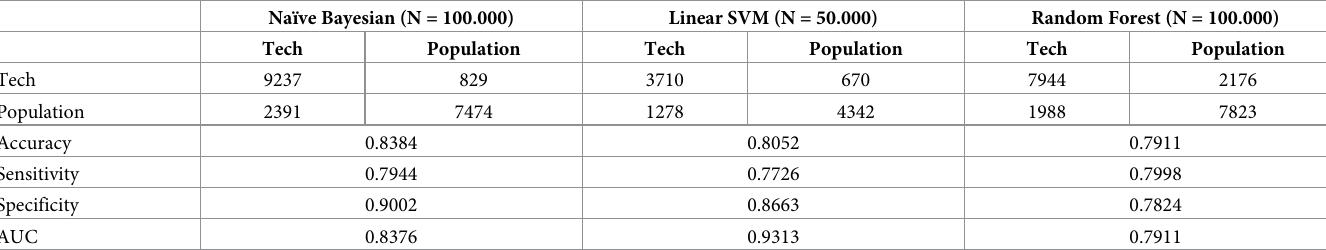
Table 2. Confusion matrix and performance measures for classified Twitter data.